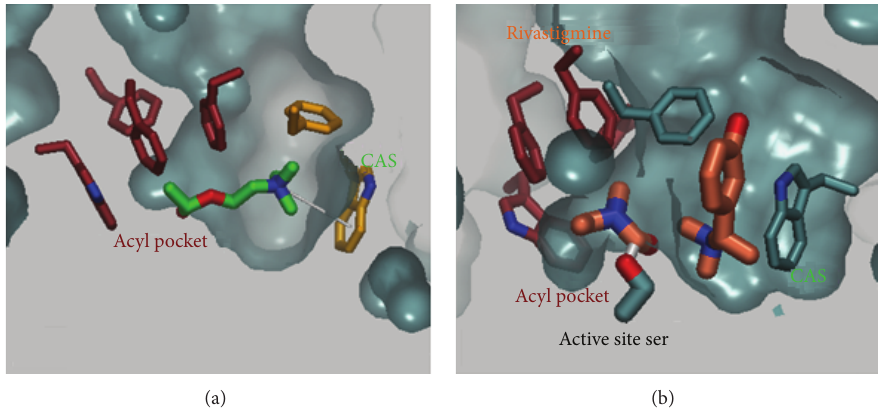
Figure 1: (a) Ligand binding sites in acetylcholinesterase. Hydrophobic residues in the gorge are shown as orange sticks. The surface of the protein is shown in cadetblue. Acetylcholine (green sticks) is shown in the catalytic anionic site (CAS). 𝜋 -Cation interactions and hydrogen bonds are shown as white dotted lines. The acyl pocket residues are shown as brown sticks. (b) Interaction between rivastigmine and acetylcholinesterase. After hydrolysis, rivastigmine, shown as coral sticks, releases the carbamate residue towards the acyl pocket and enzyme inhibition occurs. Images were taken from the official web site of European Bioinformatics